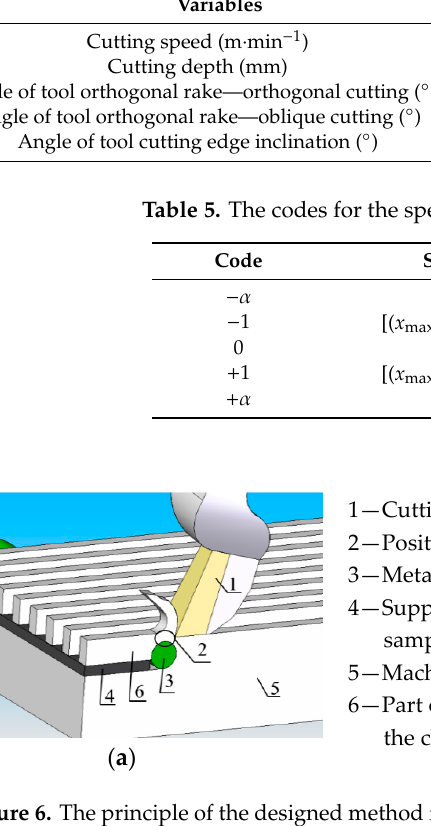
Figure 7. An example of investigated sample ( a ) before grinding, ( b ) after grinding and polishing, ( c ) shear and rake angle measuring. The angle of the tool cutting edge at orthogonal cutting was κ r = 0° and at oblique cutting it was κ r = 60°. At the same time, the angle of the tool of cutting edge inclination λ s was also changed. Thus, it is very important to evaluate the shear angle correctly. Figure 8 shows a chip root sample, and shows how the change of the angle of main cutting edge inclination λ s would affect the individual cross-sections of the sample.